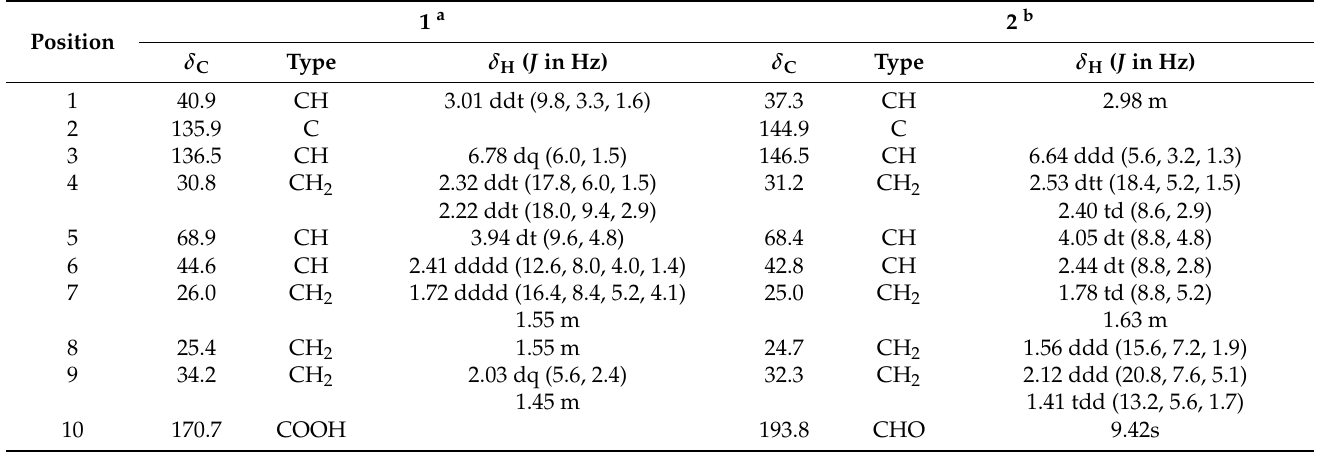
Table 1. 1 H (400 MHz) and 13 C (100 MHz) NMR data for 1 and 2